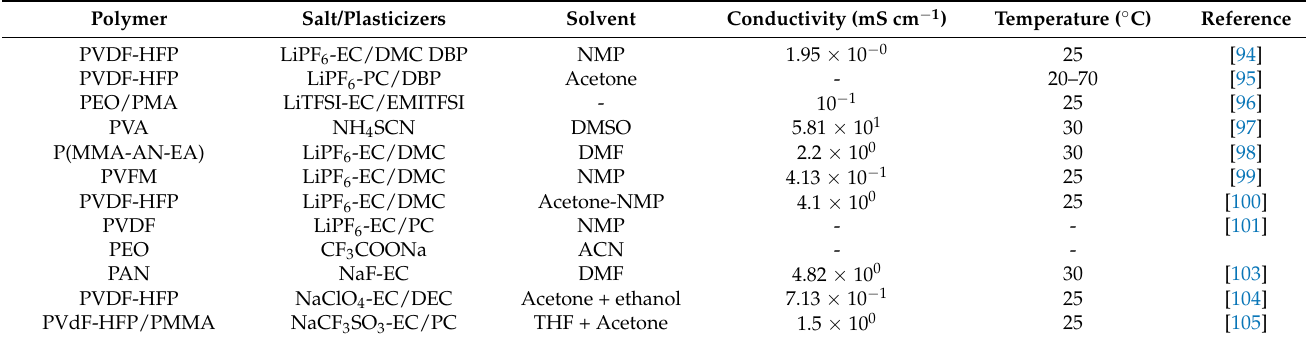
Table 2. List of GPEs with Al 2 O 3 filler with their conductivity and temperature.